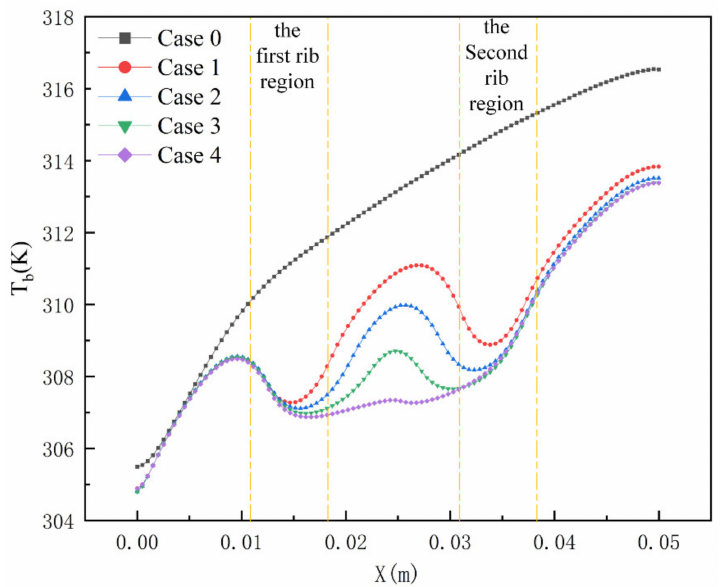
Figure 9. Temperature curve of Case 0–4 at the bottom centerline when the inlet velocity is 1.5 m/s.